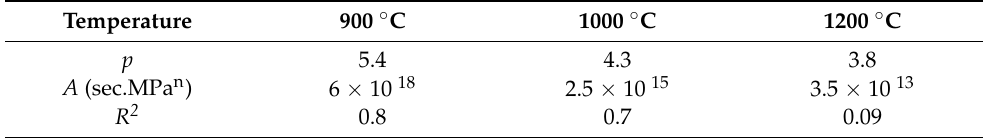
Figure 6. Static fatigue at 1200 °C on minicomposites: comparison with stress–rupture time curves for critical filaments.